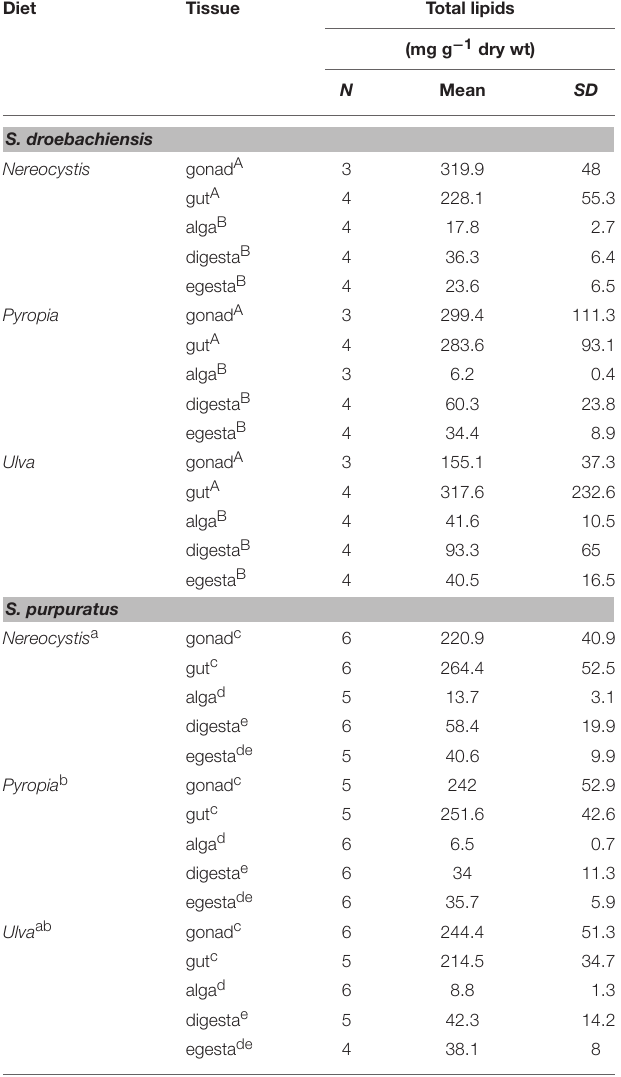
TABLE 1 | Total lipid (mean ± SD ) of tissues from S. droebachiensis and S. purpuratus feeding assays. Diet